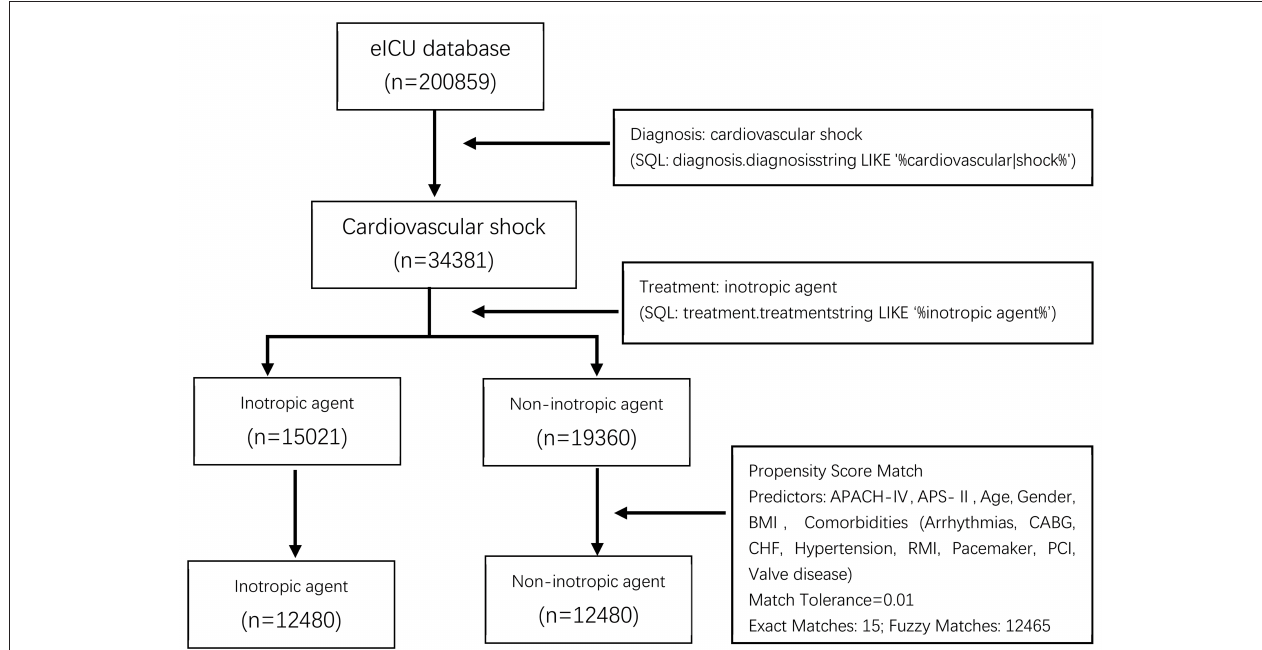
FIGURE 1 | Process of selecting the study subjects. eICU, The Philips Electronic ICU; SQL, Structured Query Language; BMI, Body Mass Index; APACH-IV, acute physiology and chronic health evaluation score IV; APS-II, simplified acute physiology score II; CABG, Coronary Artery Bypass Grafting; CHF, congestive heart failure; RMI, Remote Myocardial Infarction; PCI, Procedural Coronary